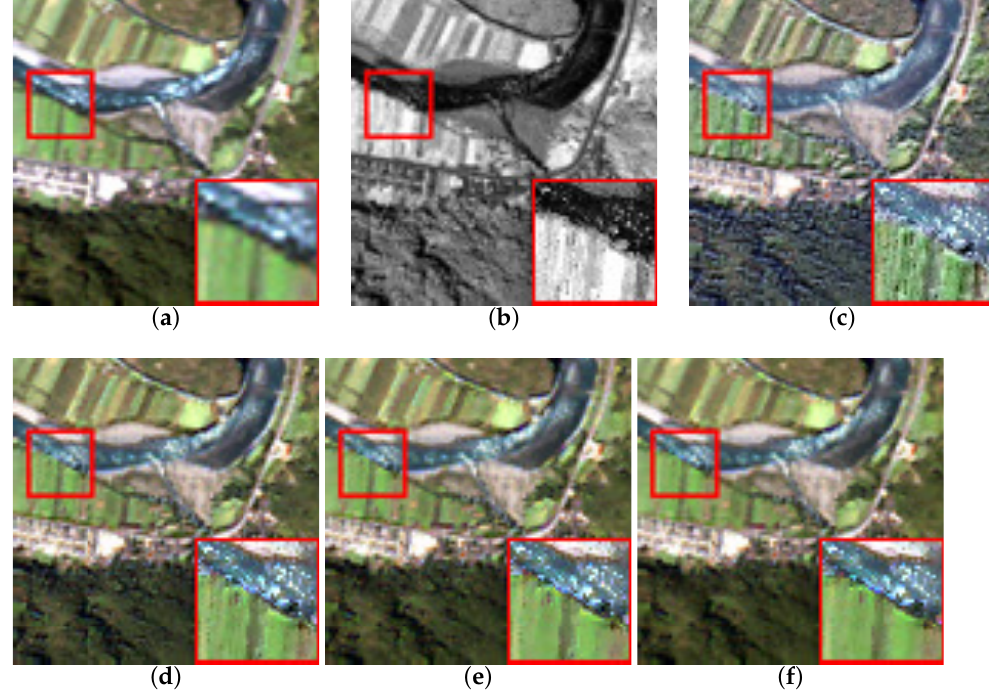
Figure 2. Results of IKONOS satellite data fusion. ( a ) Upsampled MS. ( b ) PAN. ( c ) AIHS. ( d ) IAIHS. ( e ) First stage. ( f ) Second